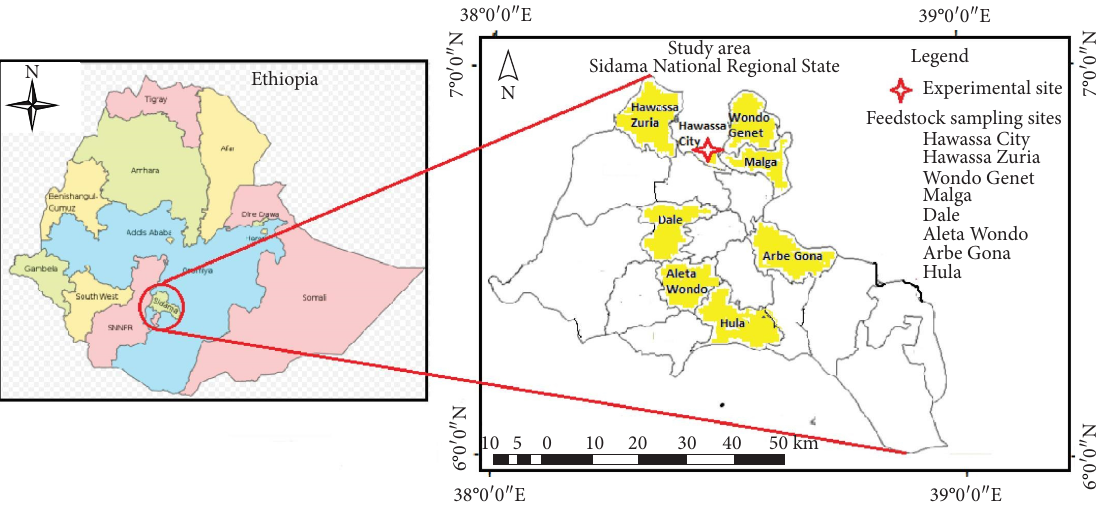
Figure 1: Map of the study area, Sidama National Regional State,